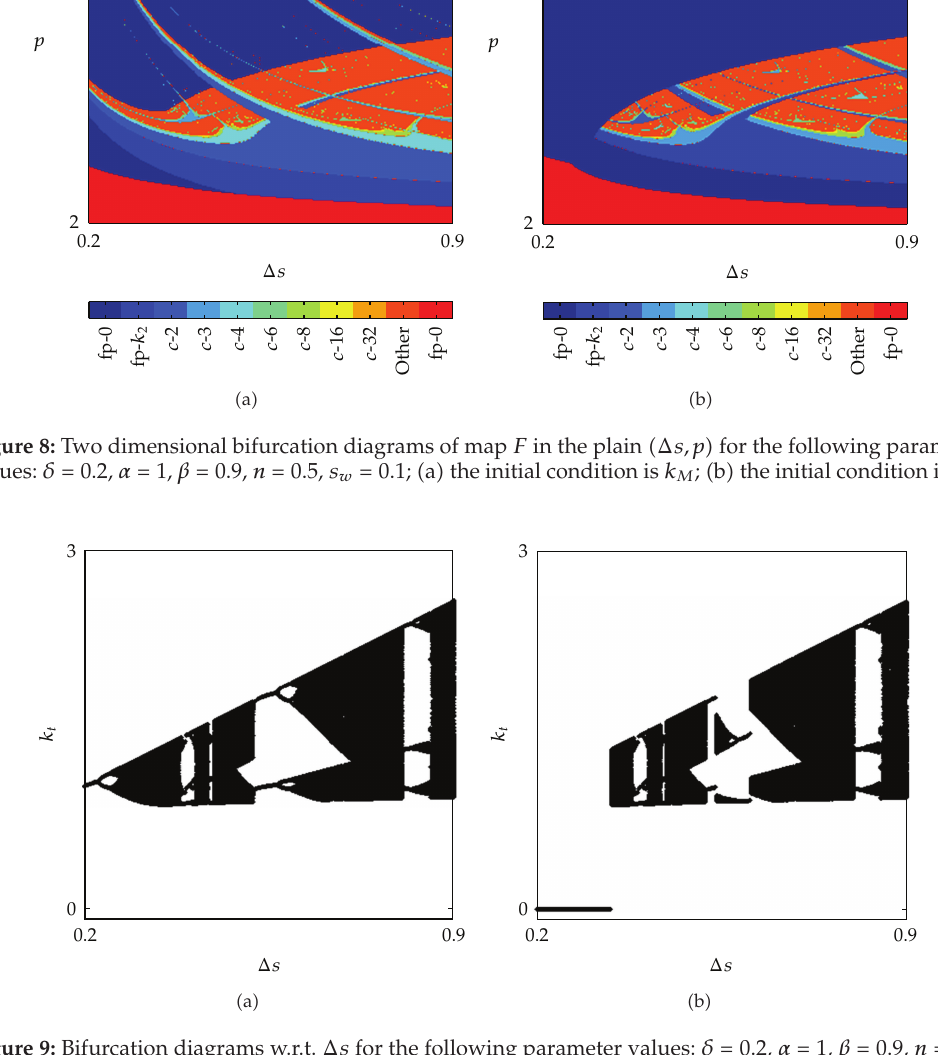
Figure 9: Bifurcation diagrams w.r.t. Δ s for the following parameter values: δ (cid:7) 0 . 2, α (cid:7) 1, β (cid:7) 0 . 9, n (cid:7) 0 . 5, s w (cid:7) 0 . 1, and p (cid:7) 12; (cid:3) a (cid:6) the initial condition is k M ; (cid:3) b (cid:6) the initial condition is k m